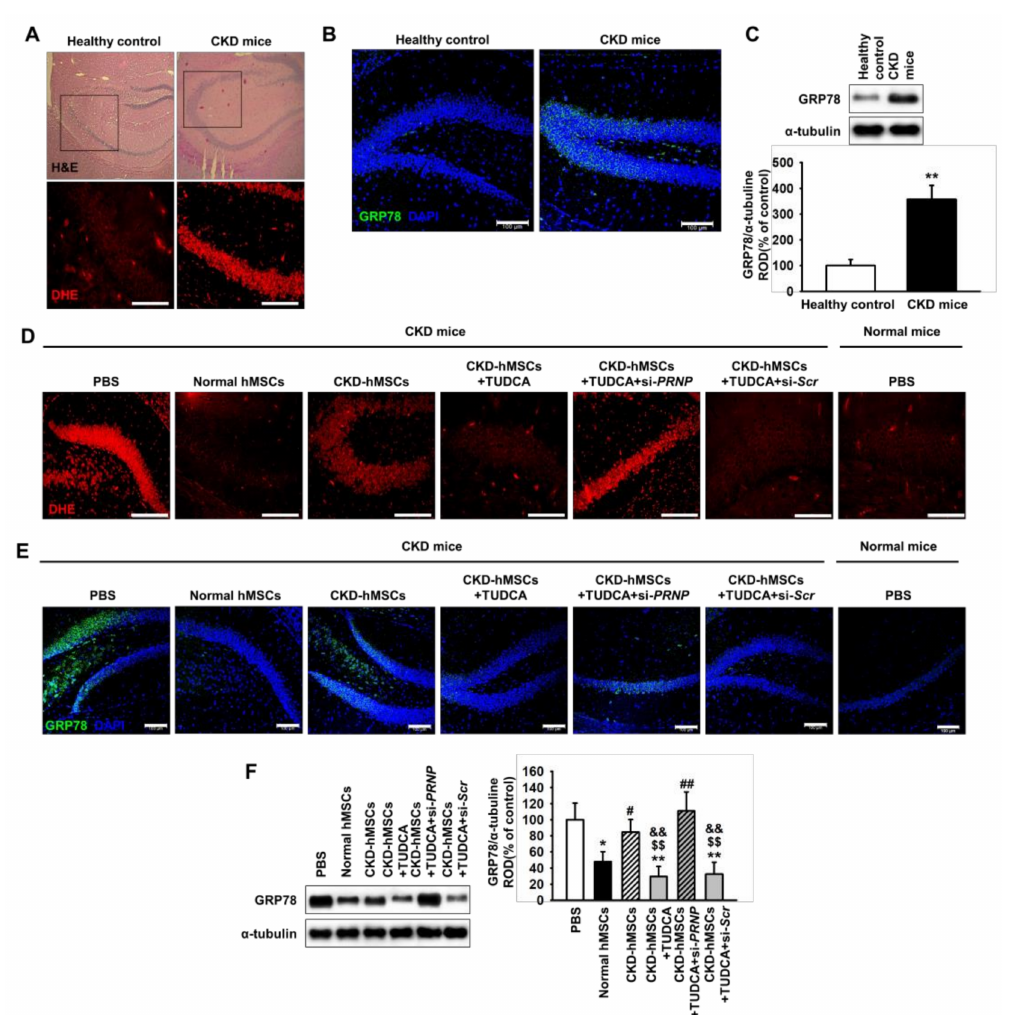
Figure 4. Co-culture of SH-SY5Y cells with TUDCA-stimulated CKD-hMSCs increases the activity of anti-oxidant enzymes via upregulation of PrP C . ( A ) In healthy mice ( n = 3) or murine CKD model ( n = 3), hematoxylin and eosin (H and E; upper images) staining and dihydroethidium (DHE, red; cropped images) staining were performed on hippocampus sections. ( B ) Immunofluorescence staining for glucose-regulated protein 78 (GRP78) in the hippocampus of a CKD mouse ( n = 3). Scale bars = 100 µ m. ( C ) Western blot analysis for GRP78 in the hippocampus of a healthy mouse and a CKD mouse ( n = 3). The protein levels were determined by densitometry relative to α -tubulin. ( D ) DHE staining (red) the hippocampus of a murine CKD model was injected with either phosphate buffer saline (PBS) or each type of hMSCs. For each mouse ( n = 3), the hippocampus was isolated and analyzed 25 days after the first injection. ( E ) Immunofluorescence staining for GRP78 in the hippocampus of a murine CKD model was injected with either PBS or each type of hMSCs ( n = 3). Scale bar =100 µ m. ( F ) Western blot analysis for GRP78 in the hippocampus of a murine CKD model ( n = 3). The protein levels were determined by densitometry relative to α -tubulin. Statistical analysis: Values represent the mean ± SEM. (C) ** p < 0.01 vs. healthy control. ( F ) * p < 0.05, ** p < 0.01 vs. PBS, # p < 0.05, ## p < 0.01 vs. normal hMSCs, $$ p < 0.01 vs. CKD-hMSCs, && p < 0.01 vs. CKD-hMSCs + TUDCA + si- PRNP